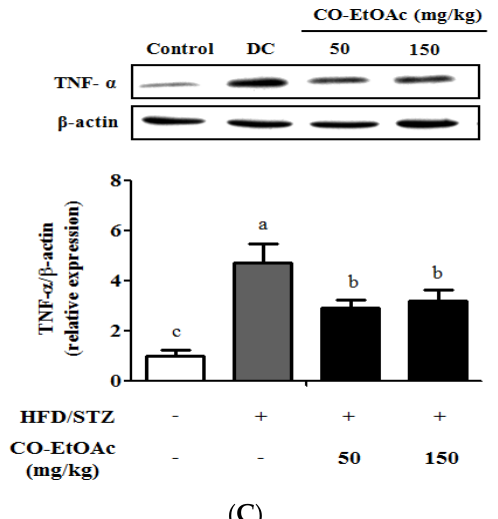
Figure 5. Effects of OE-EtOAc on the expression of hepatic inflammatory cytokines. ( A ) Relative mRNA levels of hepatic IL-6 and TNF- α were determined using RT-qPCR. Relative protein levels of: hepatic IL-6 ( B ); and TNF- α ( C ) were examined by Western blot analysis. Data are represented as mean ± SEM ( n = 8–10). Values with different letters are significantly different ( p < 0.05) by analysis of variance (ANOVA) followed by Duncan’s multiple range tests. Quantitative values of mRNA and protein expression are expressed as folds of the control group, which is set as 1.